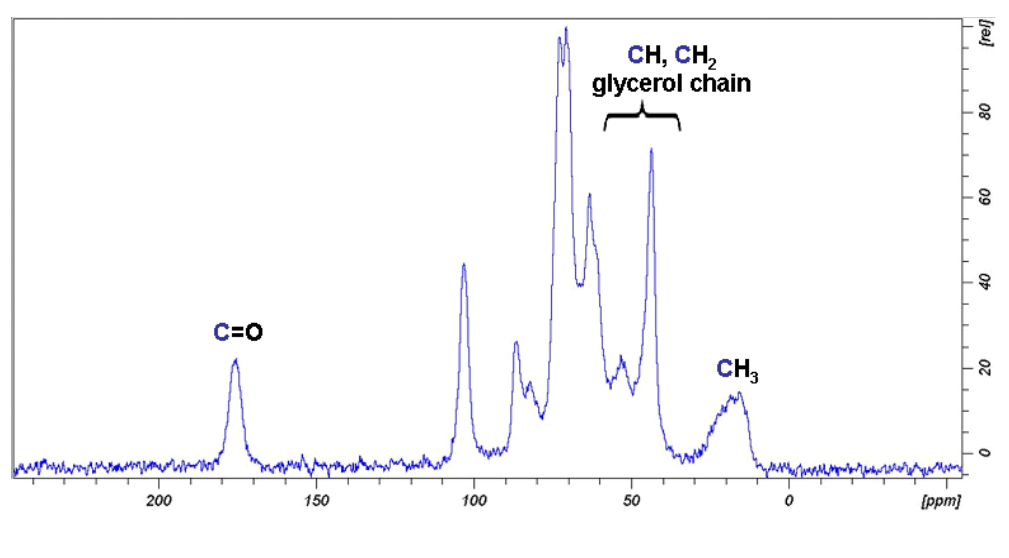
Figure 7. 13 C CP MAS NMR spectrum of sample I